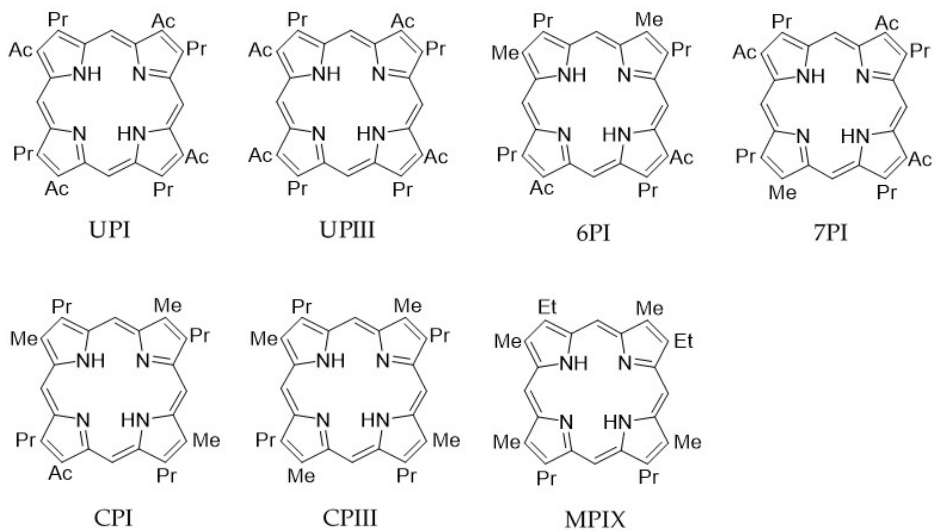
Figure 2. Structures of the porphyrin isomers. The β -positions of the four pyrrole rings are substituted with acetic acid (Ac), propionic acid (Pr), methyl (Me), and ethyl (Et). UPI: uroporphyrin I; UPIII: uroporphyrin III; 7PI: 7-carboxyl porphyrin; 6PI: 6-carboxyl porphyrin; 5PI: 5-carboxyl porphyrin;